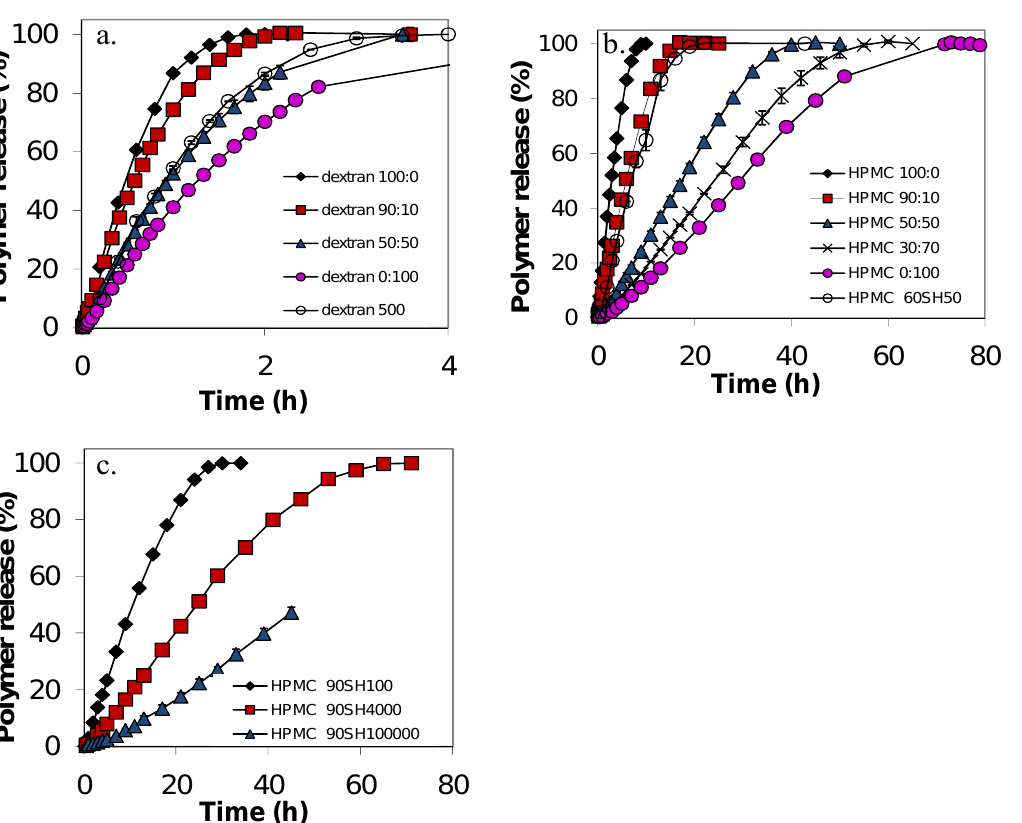
Figure 2. The release curves of: (a) dextran; (b) HPMC60SH and (c) HPMC 90SH as indicated by the figure legend. The symbols denote the calculated average from two tablets and the error bars indicates the positions of the individual